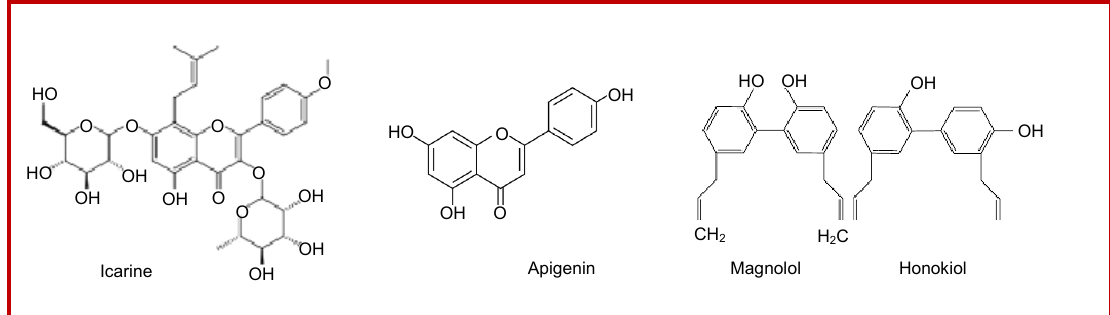
Figure 1: Chemical structure of icarine, apigenin, magnolol and